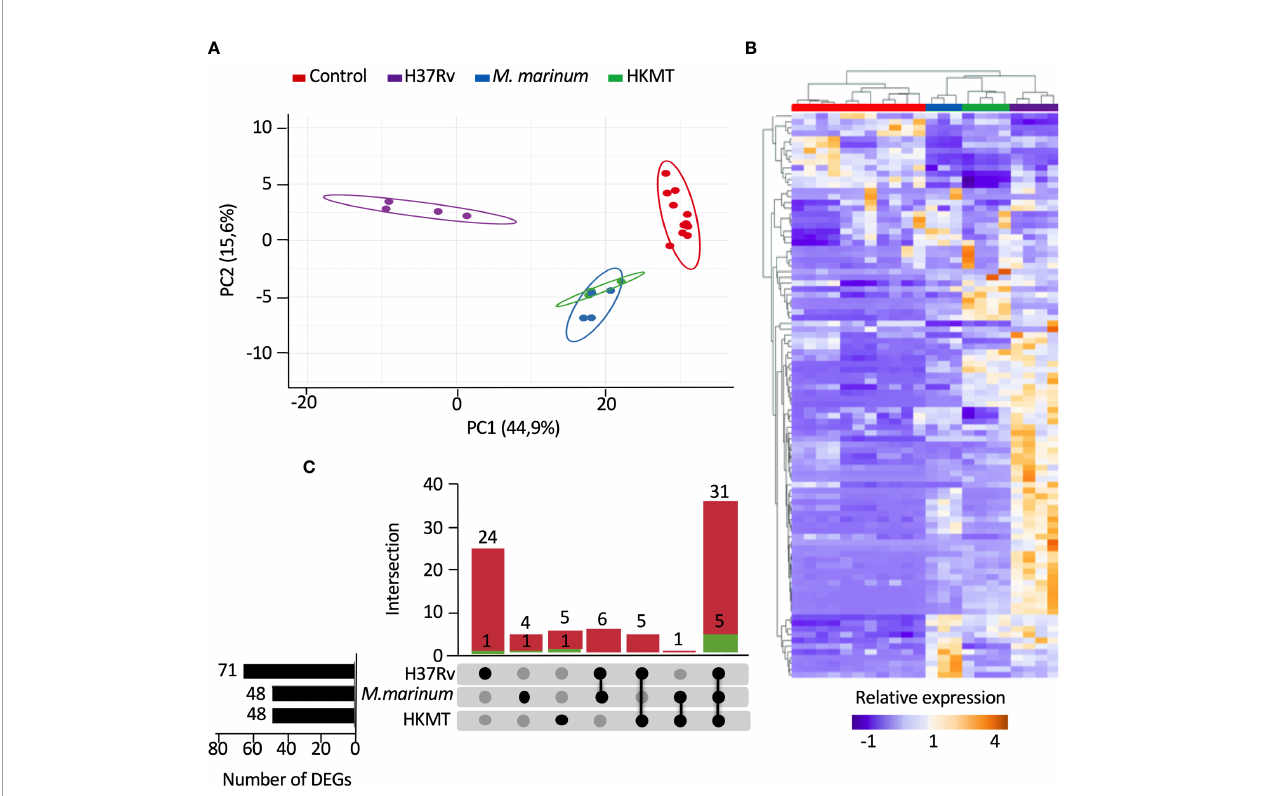
FIGURE 1 | Infection with H37Rv led to a speci fi c deregulation of macrophage in fl ammatory response-related genes. Macrophages were infected with H37Rv, M. Marinum or stimulated with HKMT for 48 hours, then total RNA was extracted and the expression levels of 184 host immune response-related genes were quanti fi ed using RT-PCR (n = 11 control, n = 3 M. Marinum , n=4 HKMT and H37Rv). For each experiment with the different mycobacterial strains, uninfected macrophages were used as control. Using Clustvis software, hierarchical clustering and principal component analysis were generated for genes, which after PCR had a CT value below 32 (98 genes). (A) Unsupervised PCA representation of the samples distribution depending on their overall relative gene expression following infection with H37Rv, M. marinum and stimulation with HKMT. Imputation was used for missing value estimation. (B) UpSet diagram representing the intersection of the DEGs relative to H37Rv or M. marinum infections or HKMT as compared with uninfected controls. In green: downregulated genes count, in red: upregulated genes count. (C) Unsupervised hierarchical clustering of the samples distribution depending on the overall relative expression of 93 genes following infection with H37Rv, M. marinum or stimulation with HKMT. Imputation was used for missing value estimation and samples were clustered using the correlation distance method and average